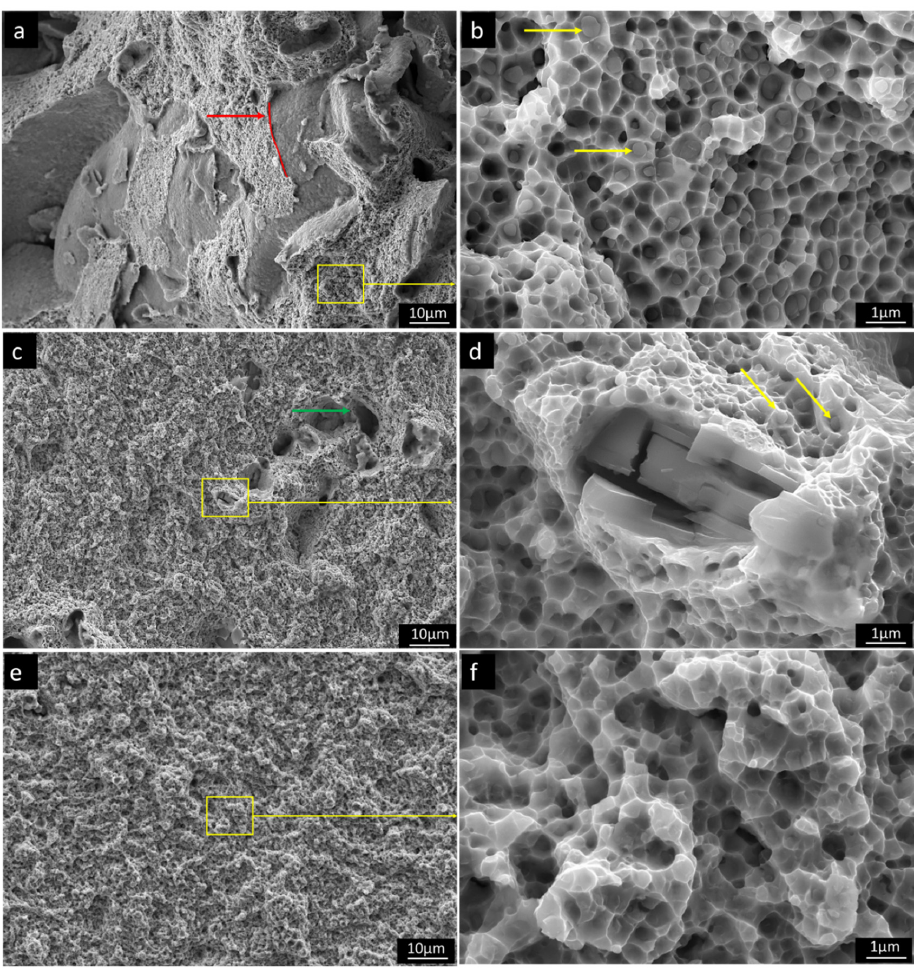
Figure 7. Fracture surfaces of Ni 1.5 Co 1.5 CrFeTi X A material; oxide particles inside the ductile dimples are marked by yellow arrows. ( a , b ) Ti0.3A, showing ductile dimples and residual porosity—the edge of the former pore is denoted by a red arrow and spline; ( c , d ) Ti0.5A showing ductile dimples and holes are denoted by green arrow with larger fractured oxide particles; ( e , f ) Ti0.7A exhibiting very flat ductile fracture surface and small dimples lacking oxide particles. Oxide particles inside the ductile dimples are marked by yellow arrows.